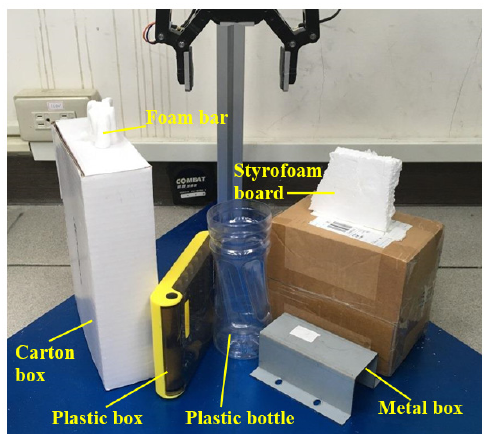
Table 3. The ILC quality parameters in the experiment.